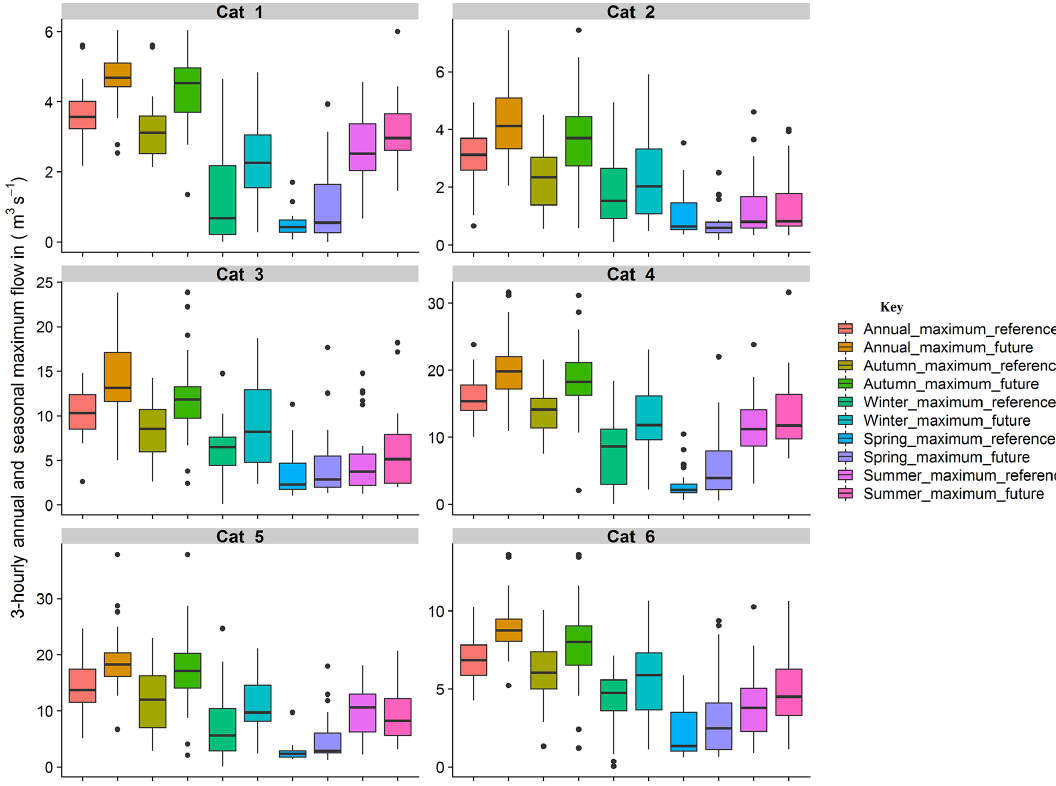
Figure 5. Distributions of the annual and seasonal maximum flow values of the 30-year